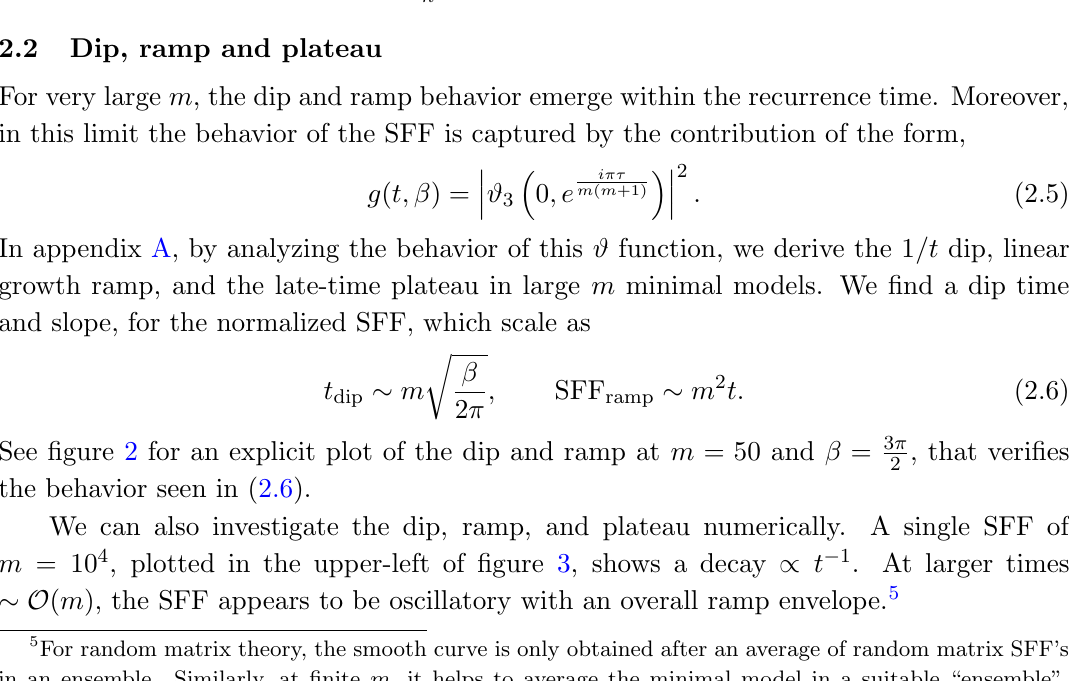
Figure 2 . SFF of the m = 50 minimal model at (cid:12) = 3 (cid:25) behave as predicted by